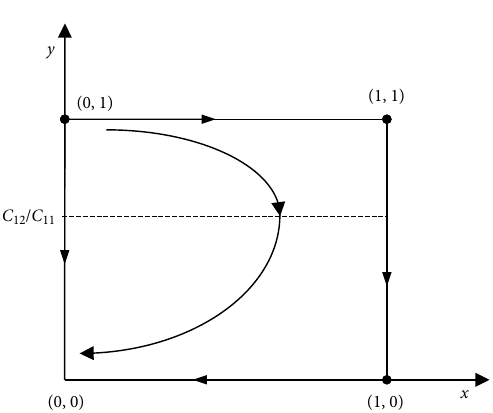
Figure 3. The dynamic diagram of the evolutionary game based on Scenario 2 of Section